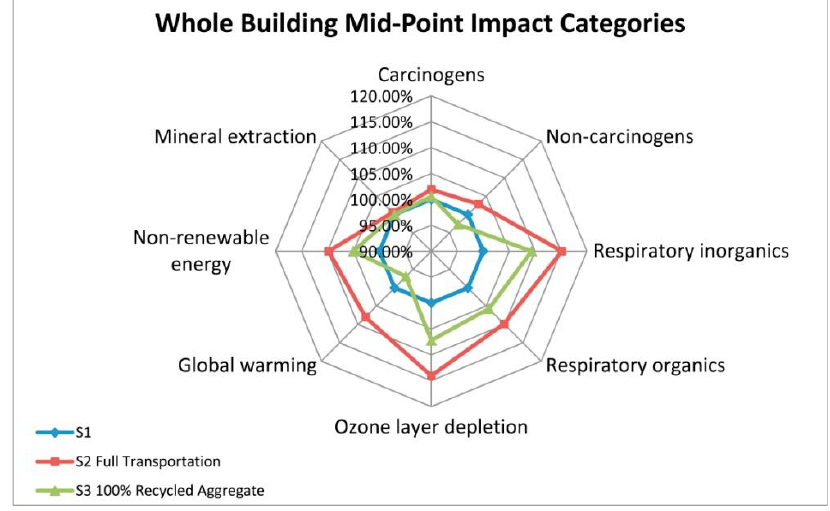
Figure 4. Impact assessment for the entire structure [17]